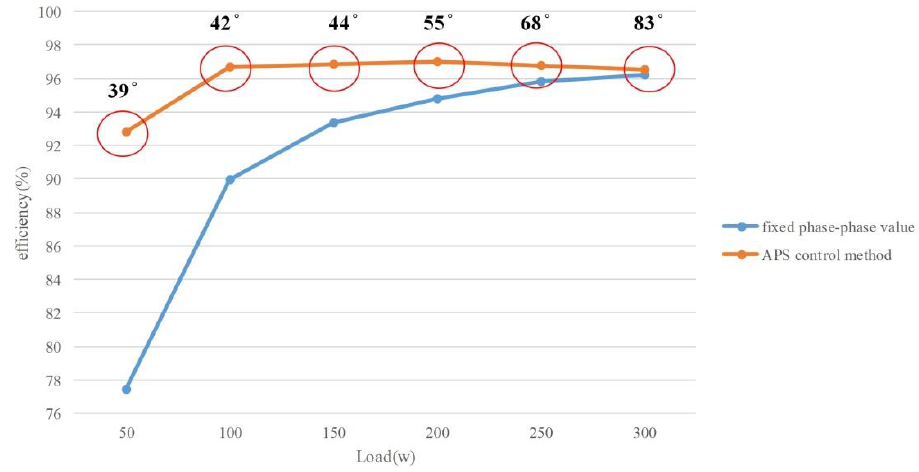
Figure 21. Measured efficiency curves of different control methods under buck-charging mode.